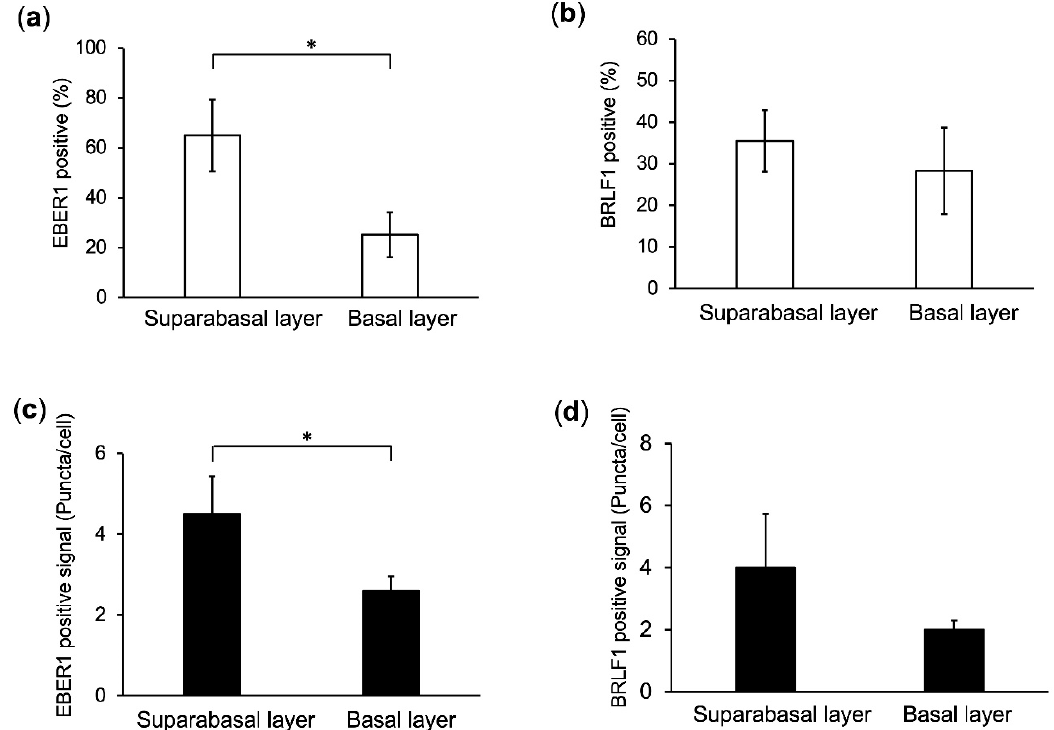
Figure 4. EBV infection is predominantly located in the suprabasal layer. ISH signal (EBER1 or BRLF1 mRNA) and p63 are stained in green and red, respectively. ( a , b ) Percentage of EBER1 positive ( a ) or BRLF1 positive ( b ) cells in suprabasal and basal layers are indicated by white columns, respectively. ( c , d ) Number of puncta showing EBER1 ( c ) or BRLF1 ( d ) ISH signals per cell are indicated by black columns, respectively. *: p < 0.05 .